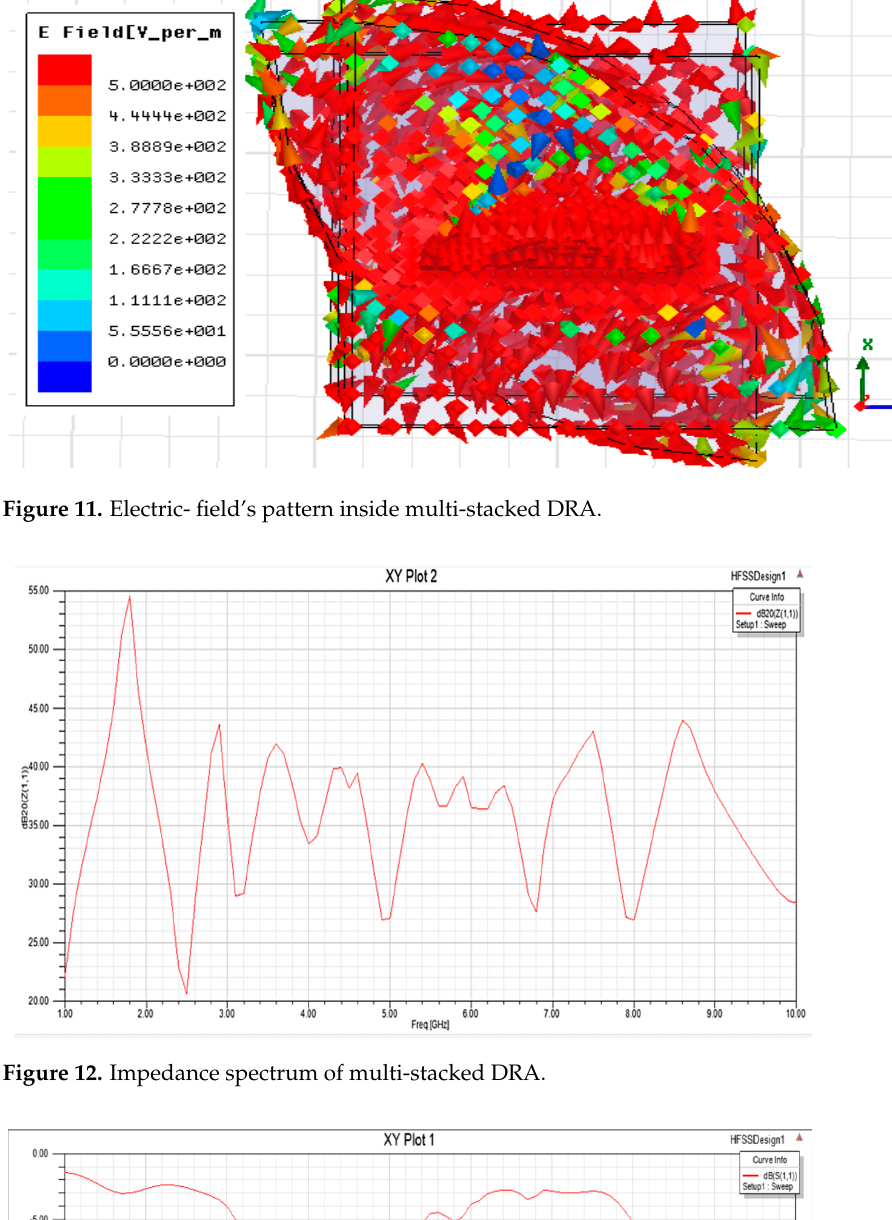
Figure 12. Impedance spectrum of multi-stacked DRA.